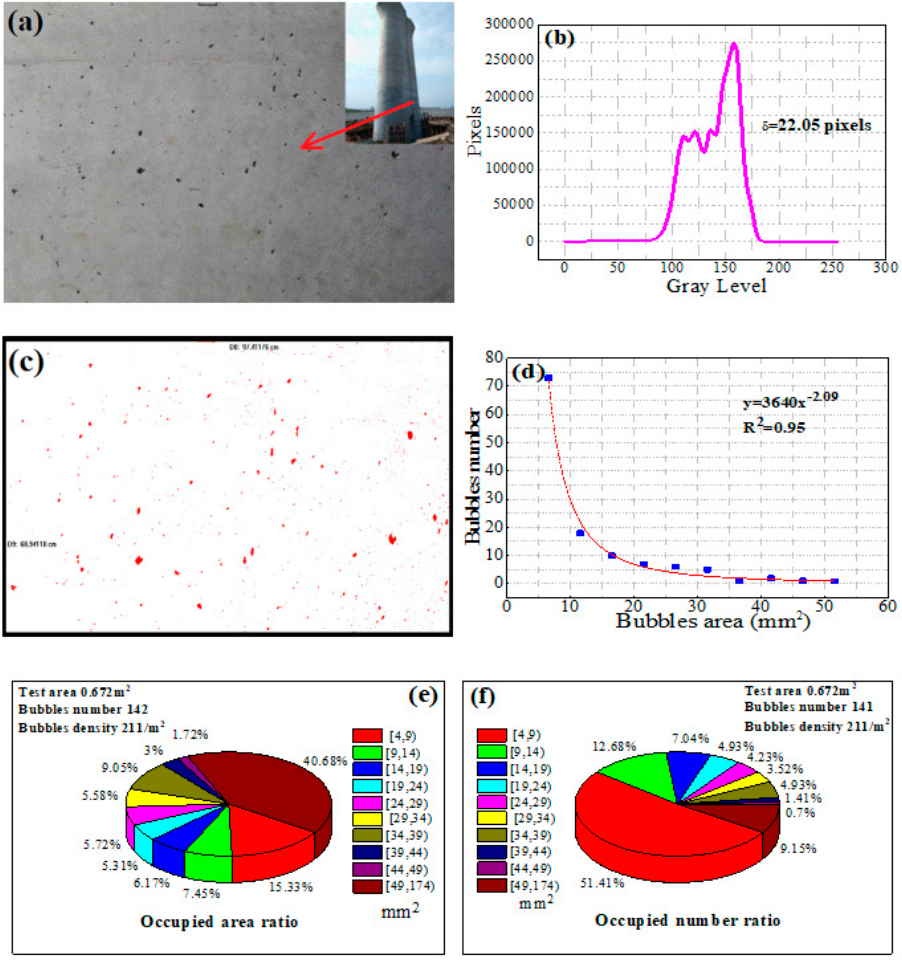
Figure 6. Concrete surface defects. ( a ) Concrete surface; ( b ) Gray level processing; ( c ) Bubble area calculation; ( d ) Relationship between bubble area and bubble number; ( e ) Percentage of bubbles area occupied; ( f ) Percentage of bubble number